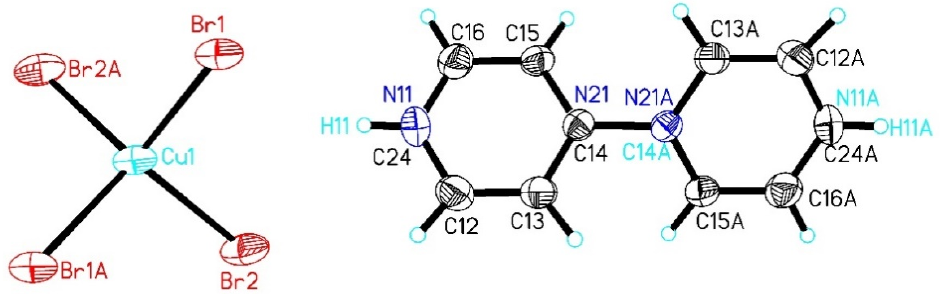
Figure 1. The molecular unit of 2 , shown as 50% probability thermal ellipsoids; hydrogen atoms are shown as spheres of arbitrary size. Disordered positions (N11 / C24 and N21 / C14) are labelled with both atom names. Symm. Op. A = − x , y , −1/2 − z . Table 2. Selected bond lengths (Å) and angles ( ◦ ) in 1 and 2 . (Symm. Op. a = − x, y, 1